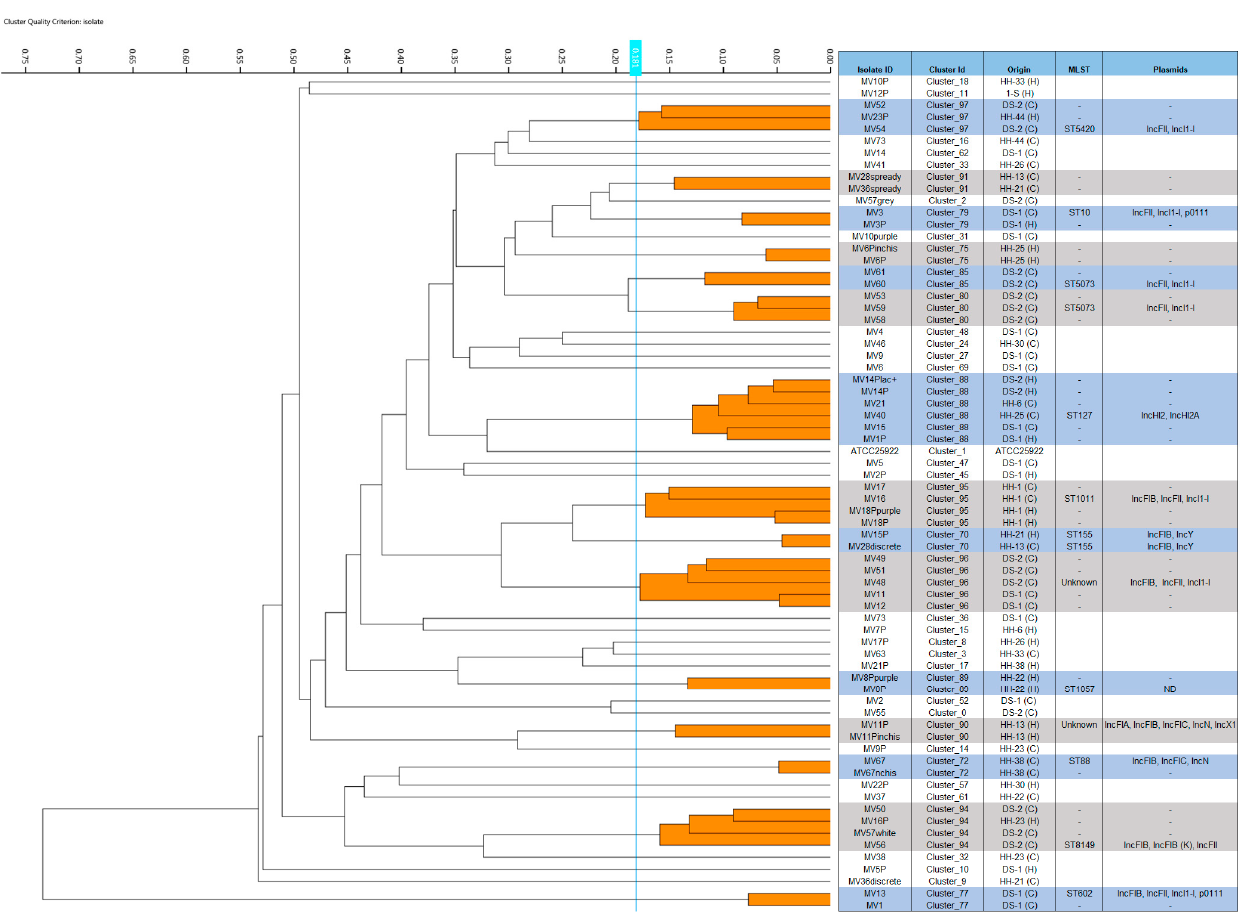
Figure 1. Dendogram obtained by clustering FTIR spectra of Escherichia coli extended ‐ spectrum cephalosporin ‐ resistant (ESC ‐ R) faecal isolates ( n = 69) from healthy dogs, dog owners, or shelter staff. The analysis was based on Euclidean average spectra of three replicates for each isolate; the blue line represents the adjusted cut ‐ off value (COV) of 0.181. Clusters composed of two isolates or more are shaded in orange. The isolate ID, cluster ID, origin, WGS ‐ based MLST, and plasmids, identified by PlasmidFinder, are shown from left to right columns. Rows are shaded in alternate colours (blue and grey), with isolates clustering together highlighted in the same shade. HH = household; DS = dog shelter; H = human; C = canine; ND = not detected.